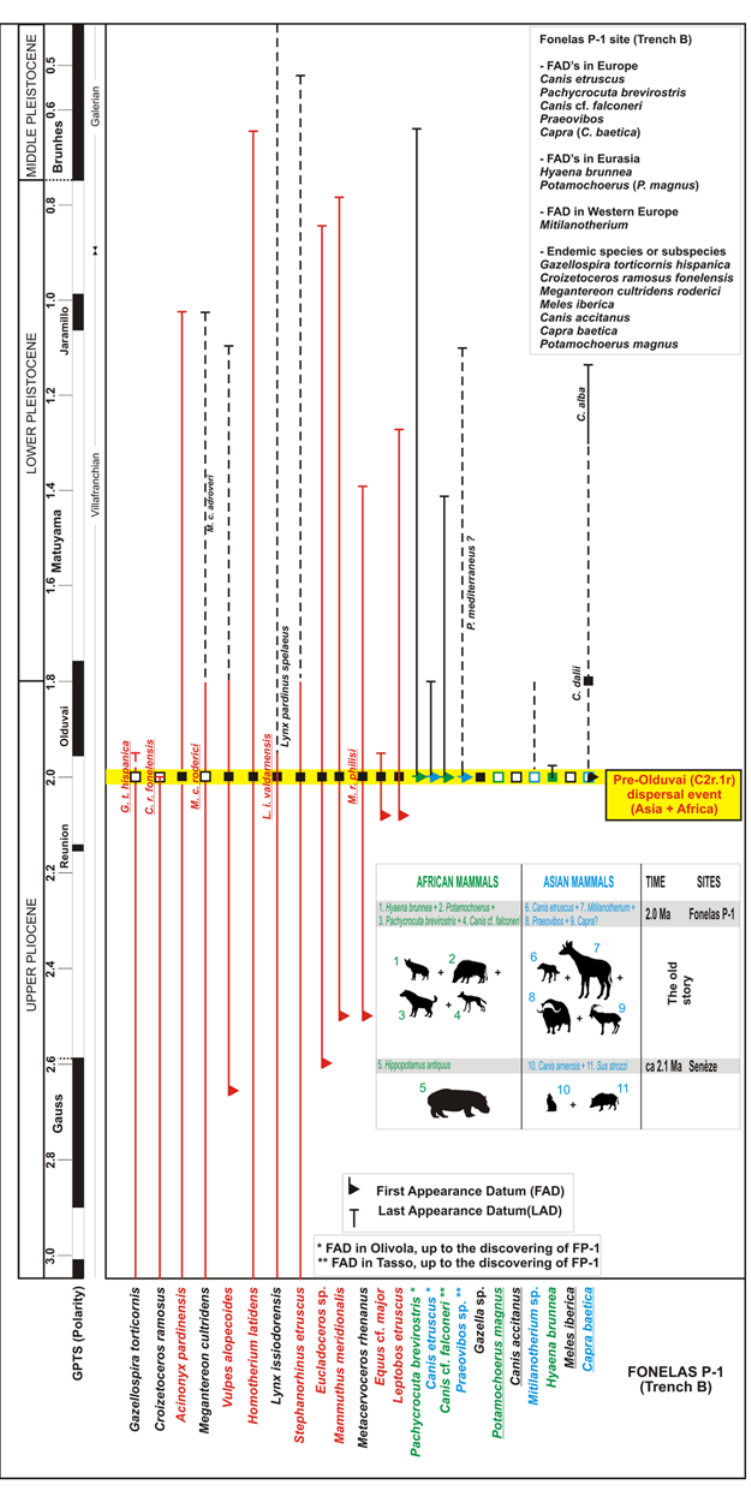
Figure 6. Biostratigraphic summary of the assemblage of large mammals in FP-1 (the position of FP-1, Trench B, is the result of the magnetostratigraphic investigation presented here). The integral analysis of the information obtained of the FP-1 palaeomastologic assemblage permits us: to establish that the singular assemblage of FP-1 is slightly older (2.0 Ma) than the Olivola + Tasso FU; to observe the noticeable increase in the FADs in the Fonelas P-1 (Trench B) assemblage; to verify the existence of zone MNQ18 in chronologies older than Olduvai; and to put forward the hypothesis of one pre-Olduvai (C2r.1r) dispersal event between 2.1 and 2.0 Ma that would bring together the Asian and African large mammals (the old story on the configuration of European pre-Pleistocene ecosystems). Future research at FP-1 and the unpublished site of M-9 might permit us to verify the presence of different primates in the GB in so early chronologies.